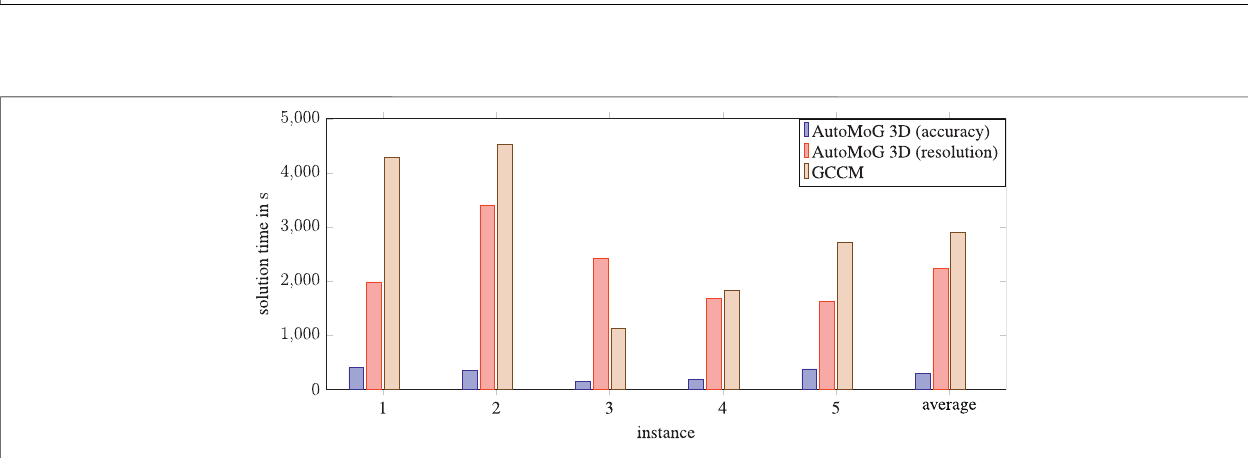
Frontiers in Energy Research |